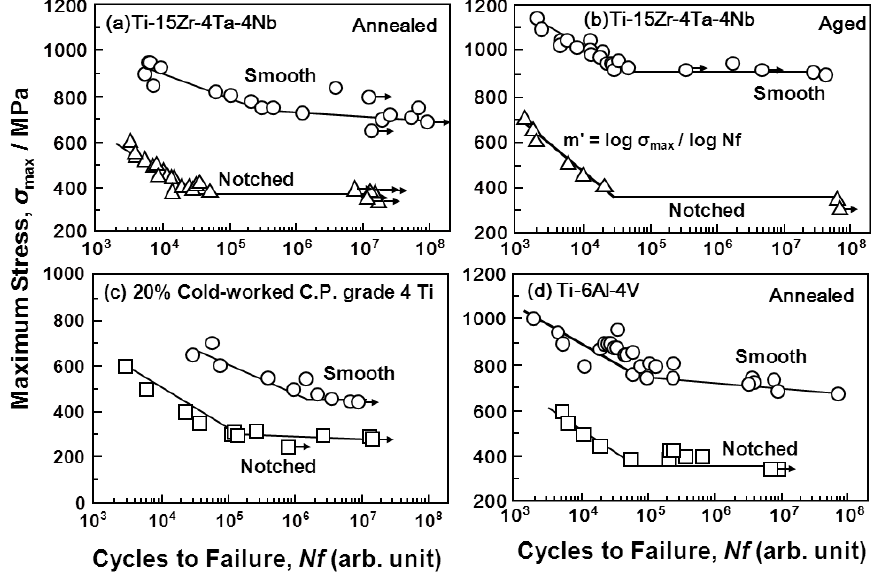
) on notched fatigue strength (σ t